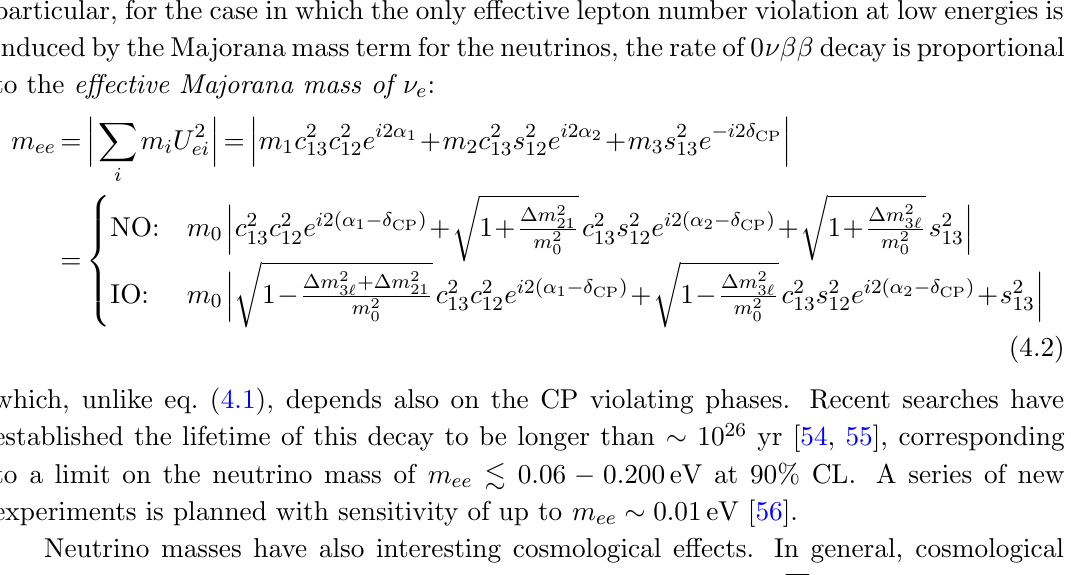
Figure 11 . 95% allowed regions (for 2 dof) in the planes ( m (cid:23) from projecting the results of the global analysis of oscillation data. The regions are de(cid:12)ned with respect to the minimum for each